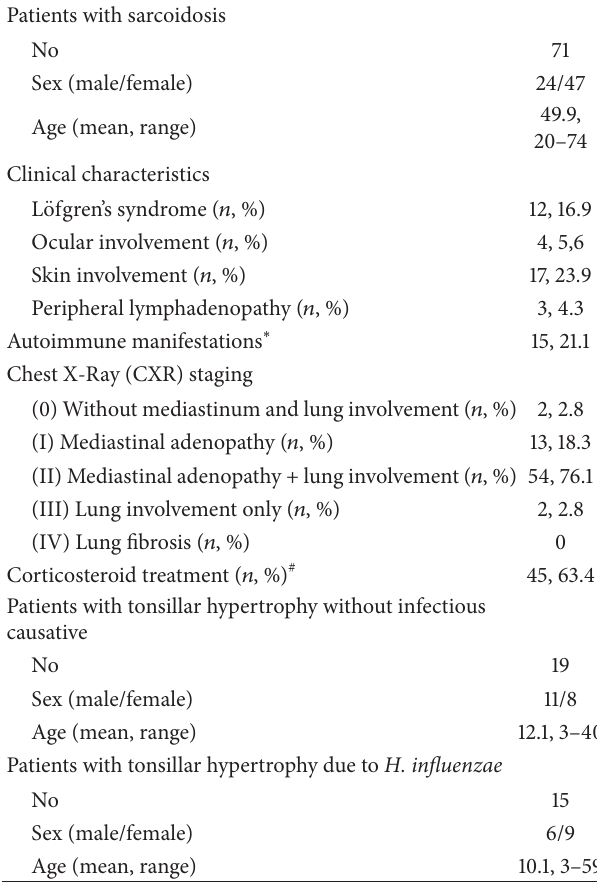
Table 1: Clinical and demographic characteristics of the patients of the